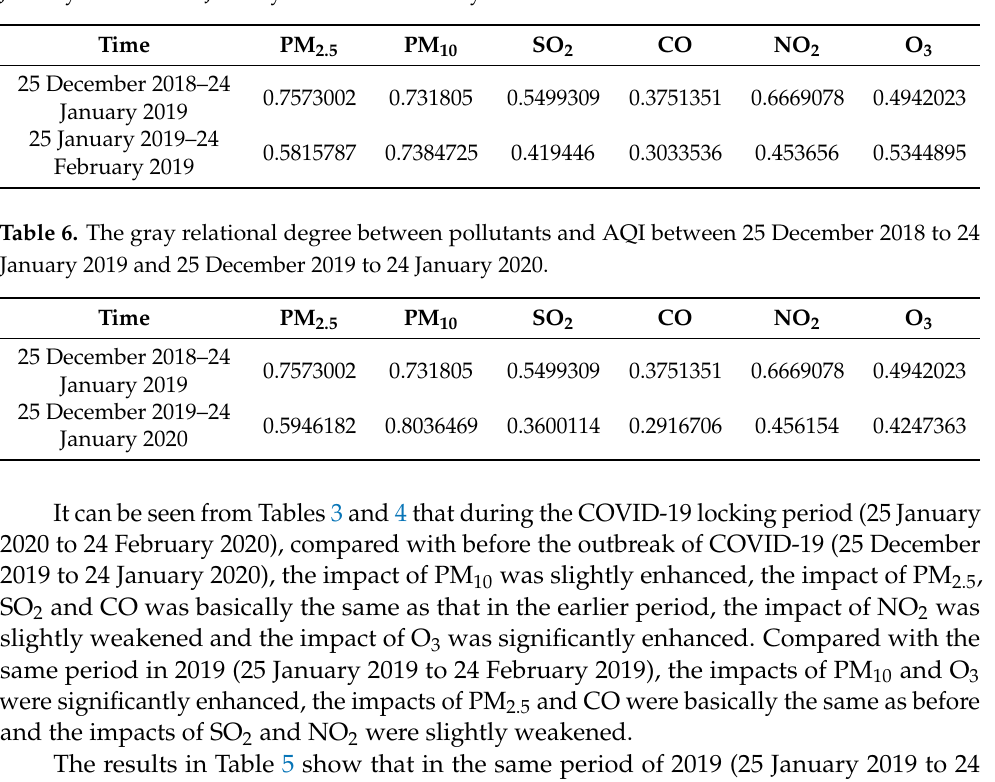
Table 5. The gray relational degree between pollutants and AQI between 25 December 2018 to 24